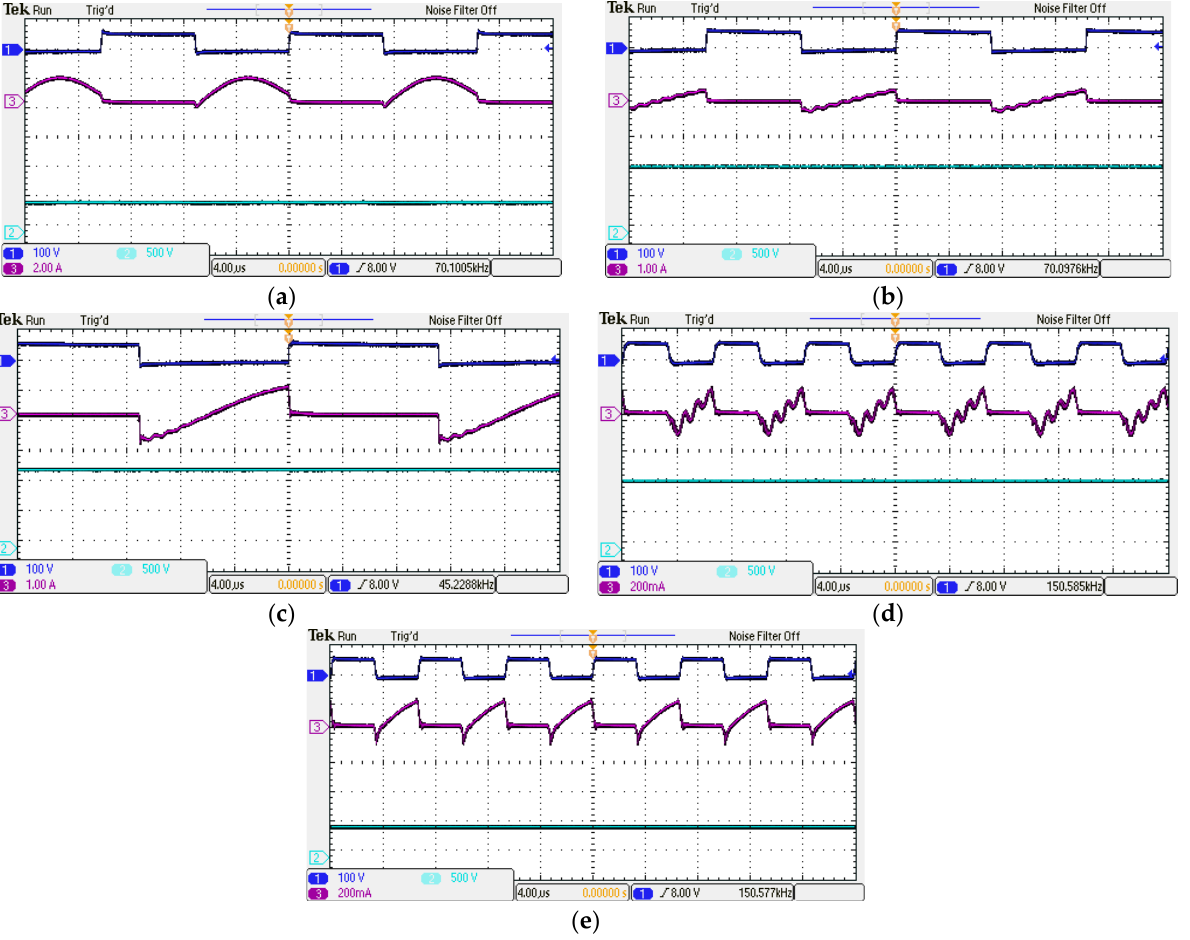
Figure 19. ZVS improvement for primary-side switches: (1) V DS ; (2) I SW ; (3) V OUT ; ( a ) full load at the resonant frequency f SW = 70 kHz; ( b ) open circuit at the resonant frequency f SW = 70 kHz; ( c ) open circuit at below resonant frequency f SW = 45 kHz; ( d ) open circuit at the above resonant frequency f SW = 150 kHz; ( e ) light load at the above resonant frequency Q = 0.2 f SW = 150